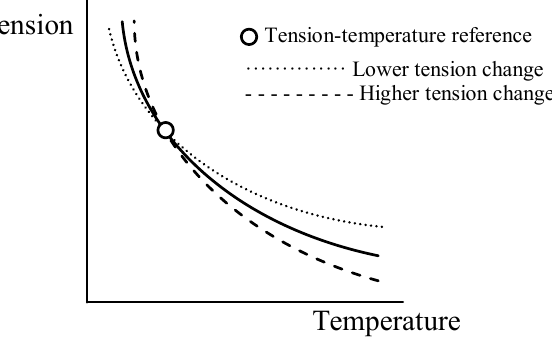
Figure 4. Tension–temperature curve with conductor parameter errors.